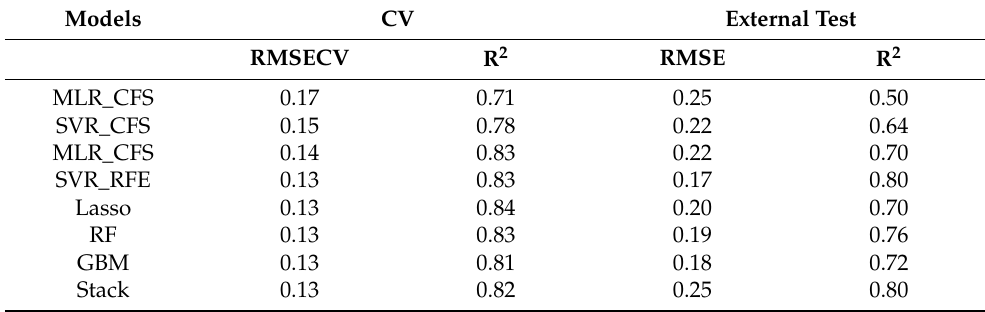
Table 1. Prediction performances of all models at pH